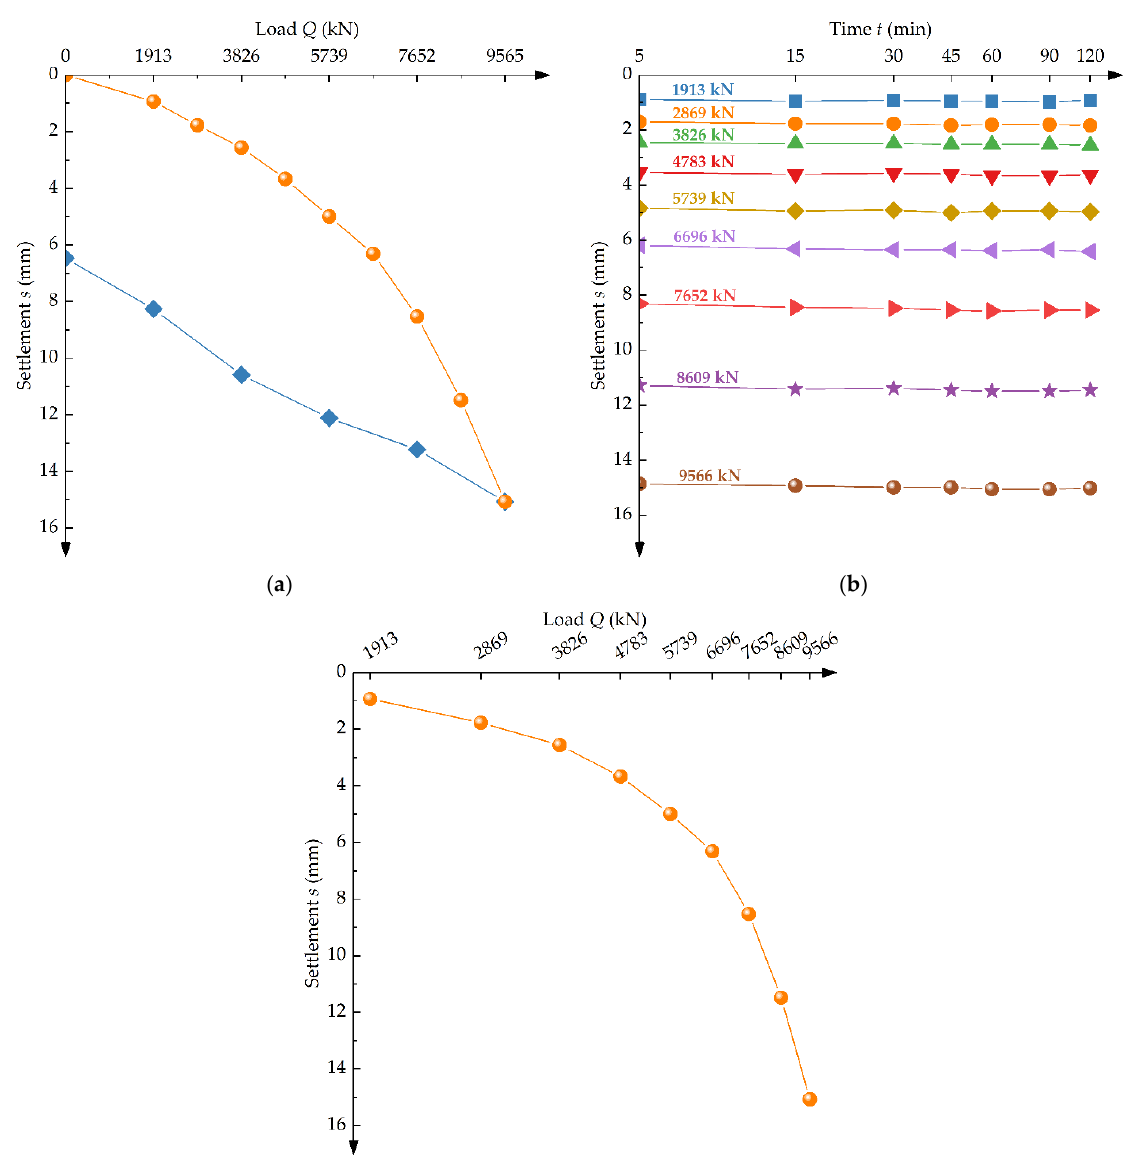
Figure 8. Vertical compressive static load test results of single pile No. 3: ( a ) load–settlement curve ( Q - S ); ( b ) settlement–time logarithm curve ( S -lg t ), and ( c ) settlement–load logarithm curve ( S -lg Q